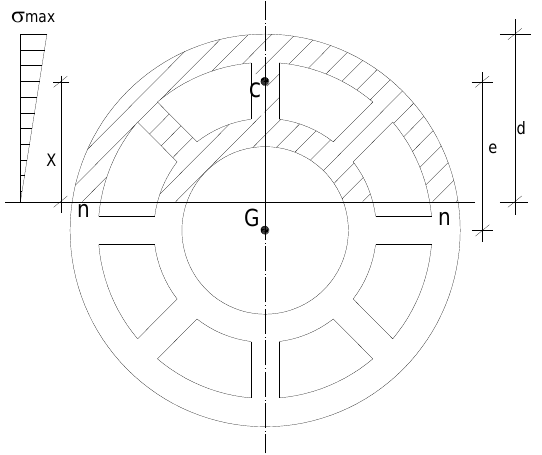
Figure 14. Compressive and tensile stresses distribution on the chimney base cross-section considering the design’s seismic action.